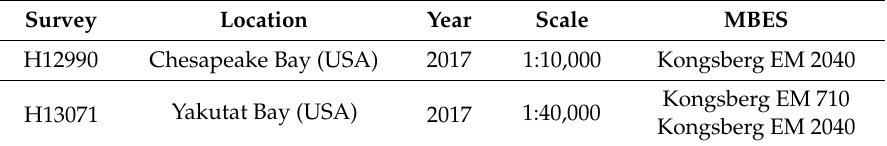
Figure 9. Bathymetric model generated using the data collected by the NOAA H12990 survey. The NOAA raster nautical charts 12331 (Chesapeake Bay Tangier Sound Northern Part) and 12333 (Potomac River Chesapeake Bay to Piney Point) are shown in the background. Bathymetric values in the color bar (in blues) are in meters and referred to the Mean Lower Low Water (MLLW) vertical datum. Axes in geographical WGS84 coordinates. Table 4. Information about the NOAA surveys presented as test datasets.